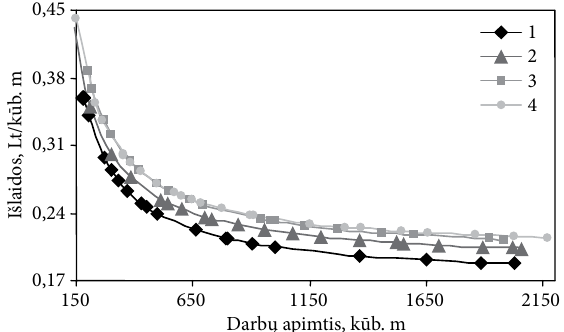
Fig. 5. The efficient selection of the soil application mechanism (bulldozer) depending on the volume of work: 1 –using bulldozer; 3 – using a „JCB“ 79 kW bulldozer; 4 – using a „Hydrema“ 55 kW bulldozer